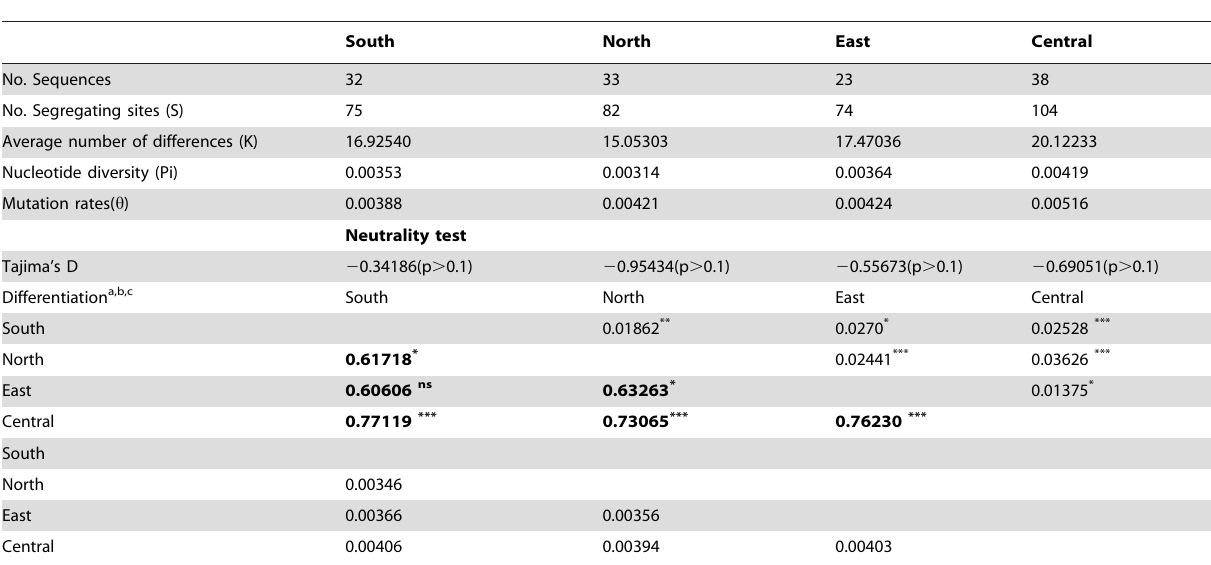
Table 3. Divergence and differentiation among geographic distributions.